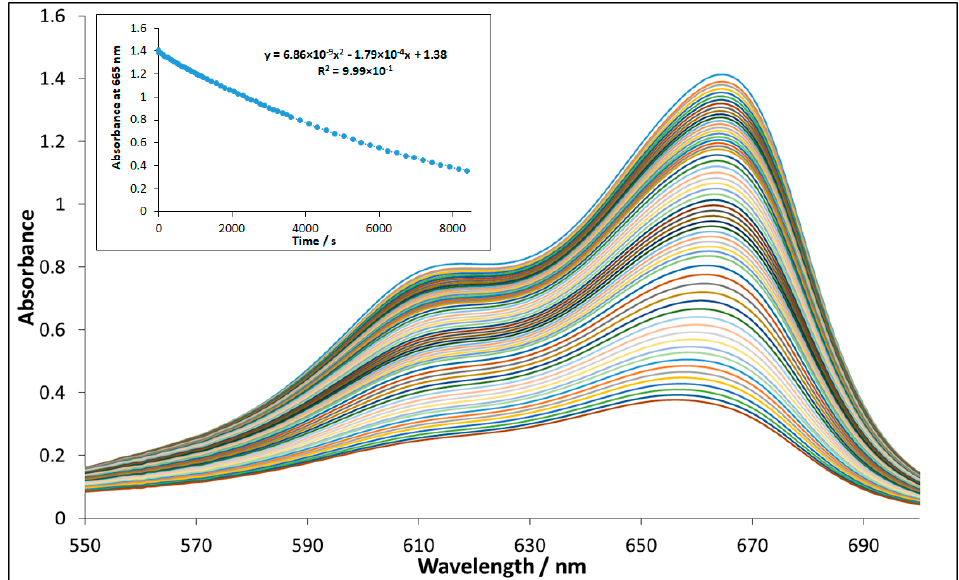
Figure 7. Spectral change during Methylene Blue degradation in photocatalytic system containing NP-3 (x = 0.4). The inset shows the absorbance vs. time plot at 665 nm. Concentrations: MB = 1.5 × 10 − 5 mol/L, NP-3 = 22.73 mg/L, initial pH = 7.5, and H 2 O 2 = 1.01 × 10 − 2 mol/L.